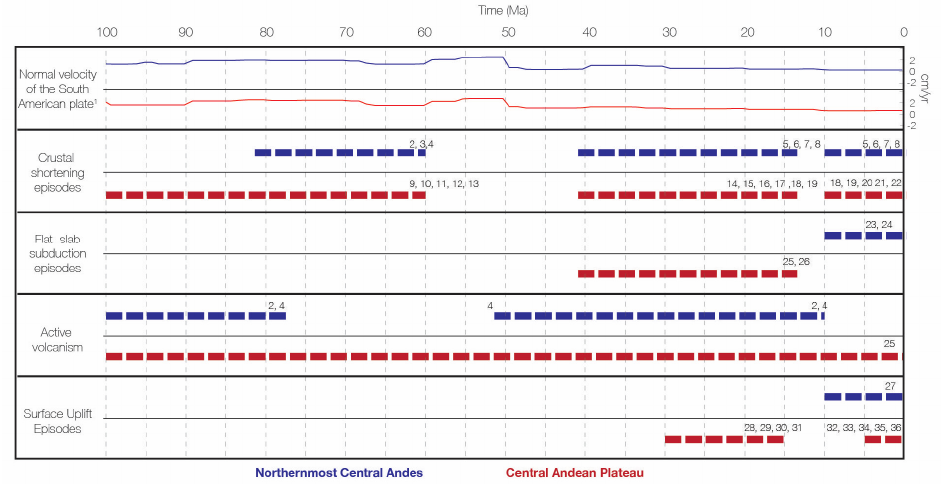
Figure 8. Comparison of the tectonic history and major orogenic events between the Central Andean Plateau (red) and the northernmost Central Andes (blue). References in figure are: (1) Maloney et al., (2013) [104], (2) George et al., (2019) [11], (3) Mégard (1984) [13], (4) Moreno et al., (2020) [25], (5) Eude et al., (2015) [7], (6) Hermoza et al., (2005) [24], (7) Calderon et al., (2017) [29], (8) Scherrenberg et al., (2014) [102], (9) Arriagada et al., (2006) [14], (10) Díaz (1977) [16], (11) Haschke and Gunther (2003) [17], (12) Mpodozis et al., (2005) [15], (13) Scheuber and Reutter (1992) [18], (14) Coutand et al., (2001) [20], (15) DeCelles et al., (2011) [22], (16) DeCelles and Horton (2003) [21], (17) Gillis et al., (2006) [23], (18) McQuarrie et al., (2008) [9], (19) McQuarrie et al., (2005) [10], (20) Echavarria et al., (2003) [26], (21) Lease et al., (2016) [28], (22) Uba et al., (2009) [27], (23) Gutscher et al., (1999) [111], (24) Gutscher et al., (2000) [105], (25) James and Sacks (1999) [109], (26) Ramos and Folguera (2009) [1], (27) this work, (28) Garzione et al., (2014) [32], (29) Leier et al., (2013) [31], (30) Saylor and Horton (2014) [30], (31) Sundell et al., (2019) [6], (32) Bershaw et al., (2010) [33], (33) Garzione et al., (2006) [34], (34) Ghosh et al., (2006) [35], (35) Graham et al., (2001) [37], and (36) Kar et al., (2016) [36].